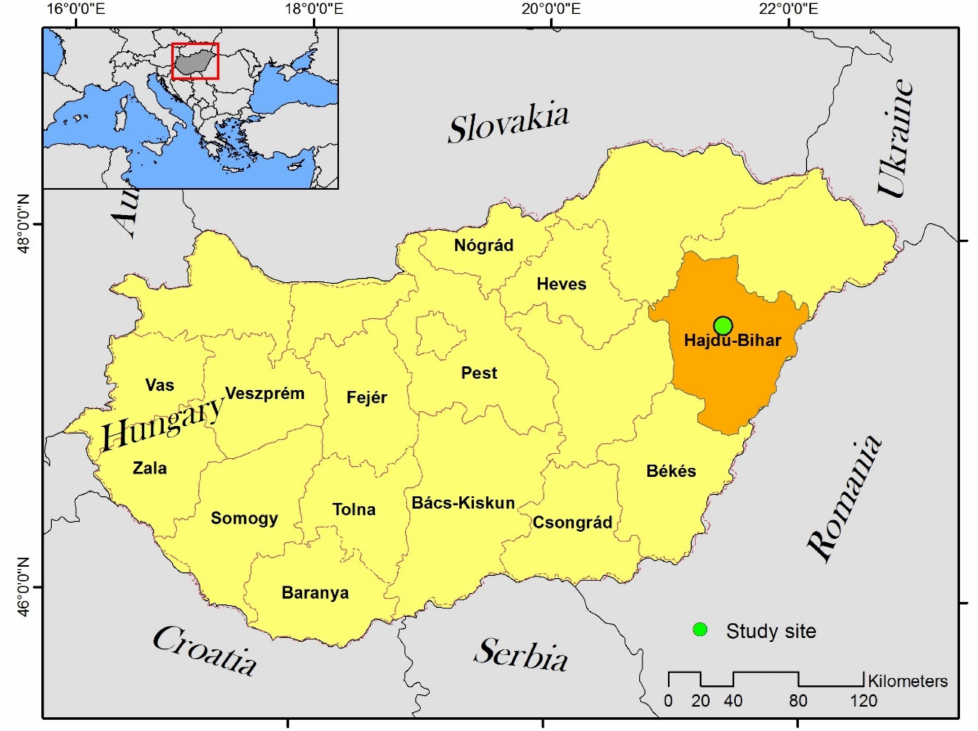
Figure 1. Location of the experiment site, Hungary, city of Debrecen.